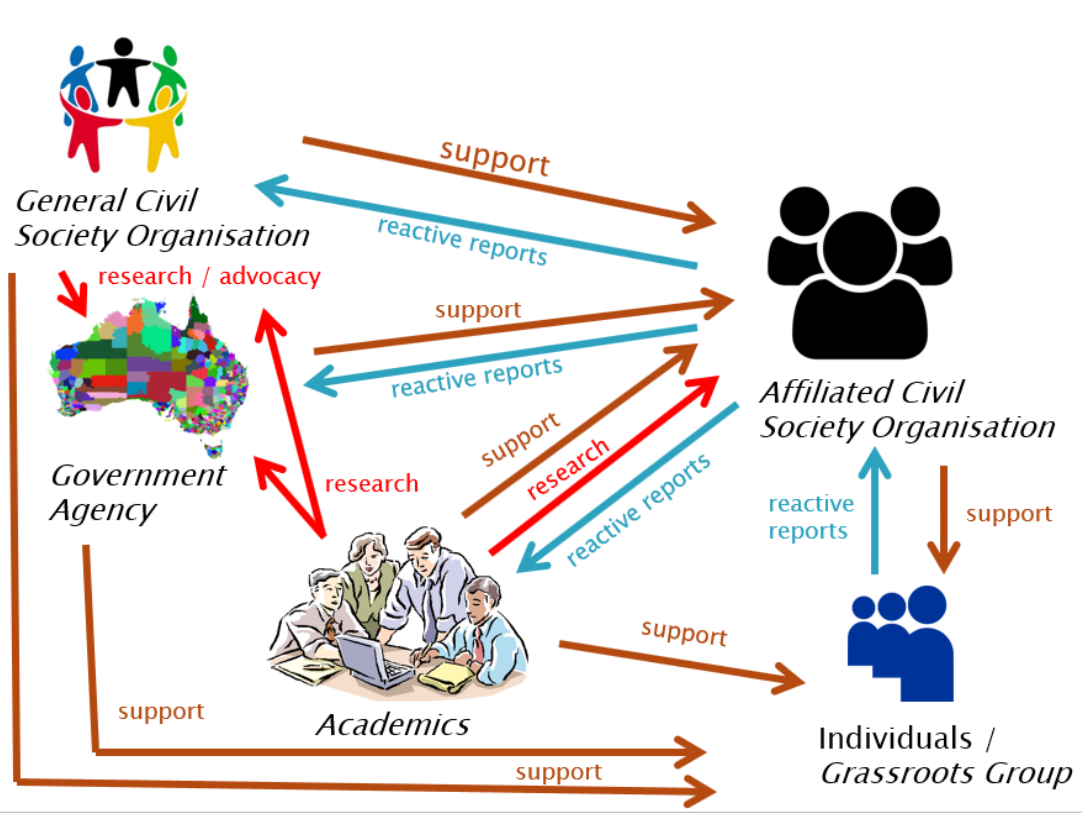
Figure 2: Actors and Interactions in the SMARTER